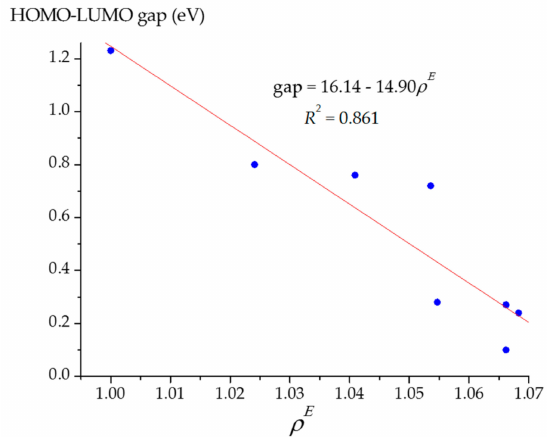
Figure 8. Correlation between the HOMO–LUMO gap and extreme topological roundness of the C 240